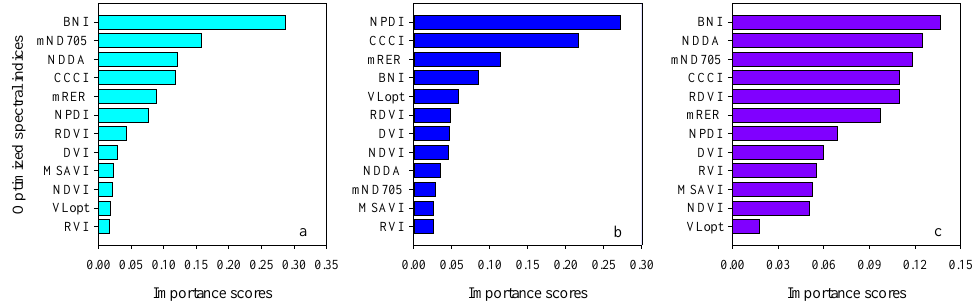
Figure 8. Importance scores both Opt-SIs in the best RF modeling for predicting potato AGB at ( a ) tuber formation, ( b ) tuber bulking, and ( c ) the combined growth stage.